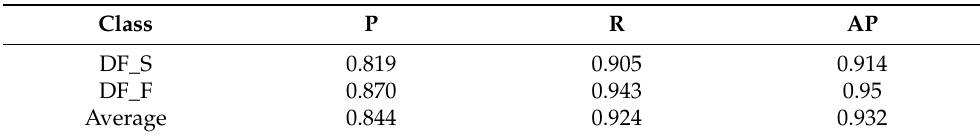
Table 2. Test results of YOLOv7.